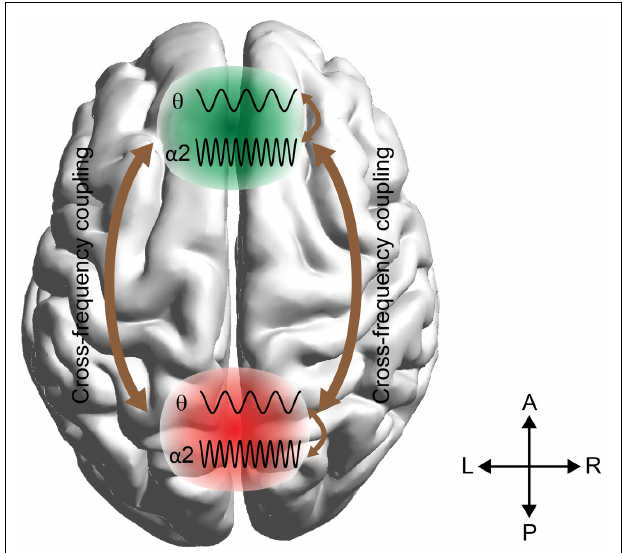
FIGURE 1 | Schematic illustrations of working memory (WM) manipulation of the visual representations. The external visual information is stored in the modality-specific posterior region by the α 2 rhythm. For manipulation of the stored representations, the cross-frequency phase coupling (CFPC) between θ – α 2 connect the frontal (F) executive regions with parieto-occipital (PO) regions where the visual and number related information is stored. Moreover, θ – α 2 interact within both F and PO